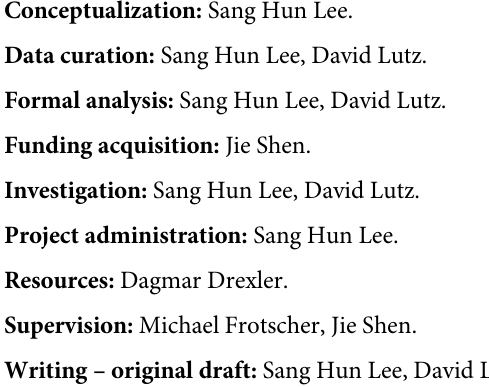
S1 Table. Quantified data set of the number of mitochondria per cross-sectional bouton profile, the size of cross-sectional bouton profile area and the density of